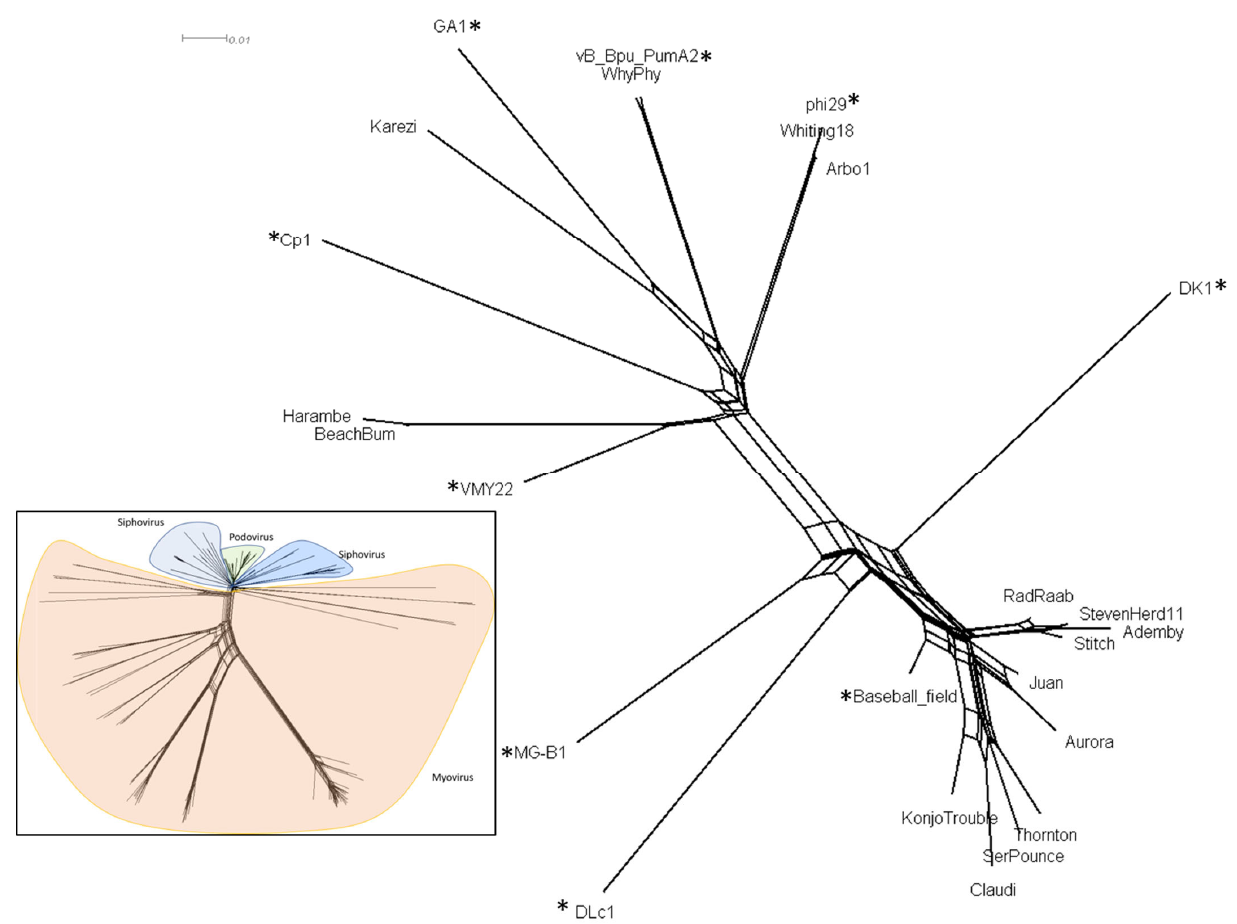
Figure 3. Protein content comparison of representative Salasmaviridae bacteriophage genomes. A profile of protein content extracted from a custom Phamerator database was visualized using Splitstree v4.0. An asterisk was used to designate phages that were added to our dataset for comparative purposes. Inset shows podovirus are separate from myovirus and siphovirus, from a database of 265 Bacillus phage genomes.